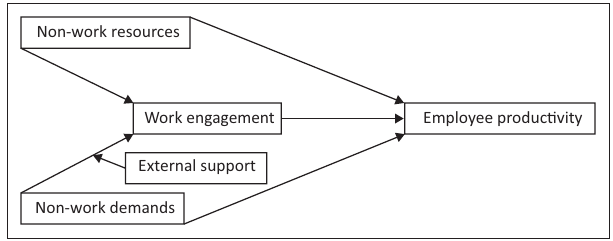
FIGURE 1: Expected relationships among the constructs in